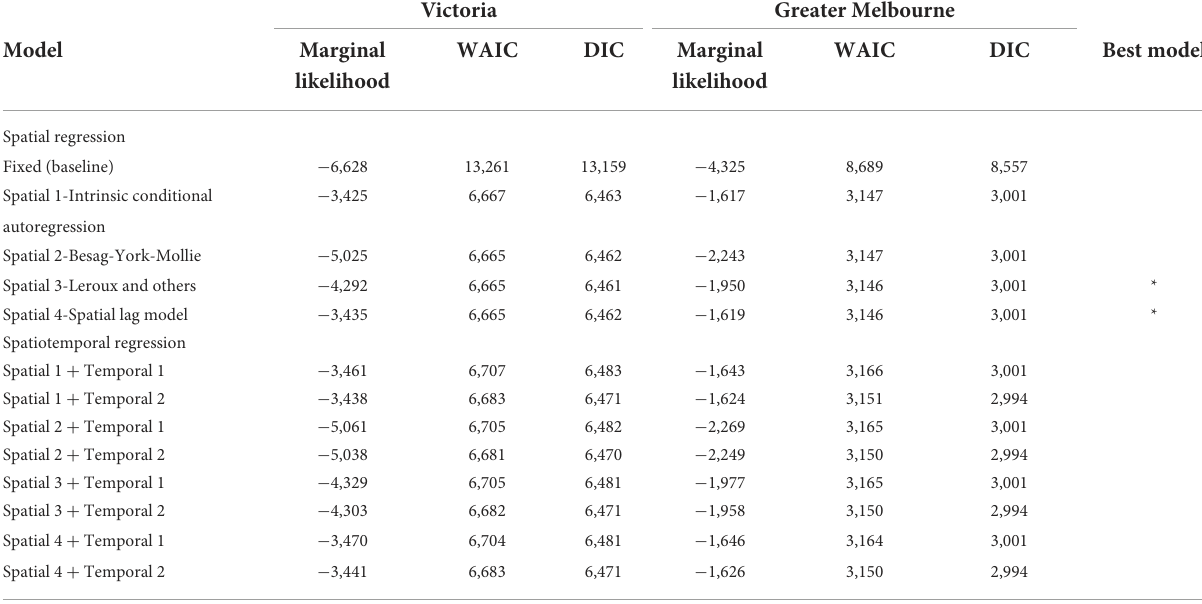
TABLE 2 Spatiotemporal analysis of standard TIA ratios in local government areas in